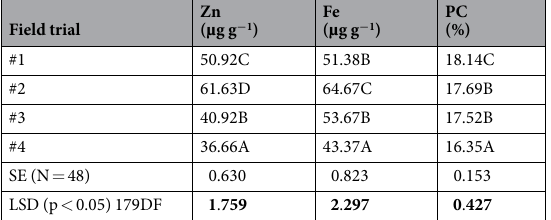
Table 4. The grain characteristics in each field trials. Values indicate means of 6 treatments × 4 replicates × 2 genotypes. Means with the same letter are similar at 5% significance level using Fischer’s LSD. LSD values are in bold font to differentiate from data values. PC denotes protein